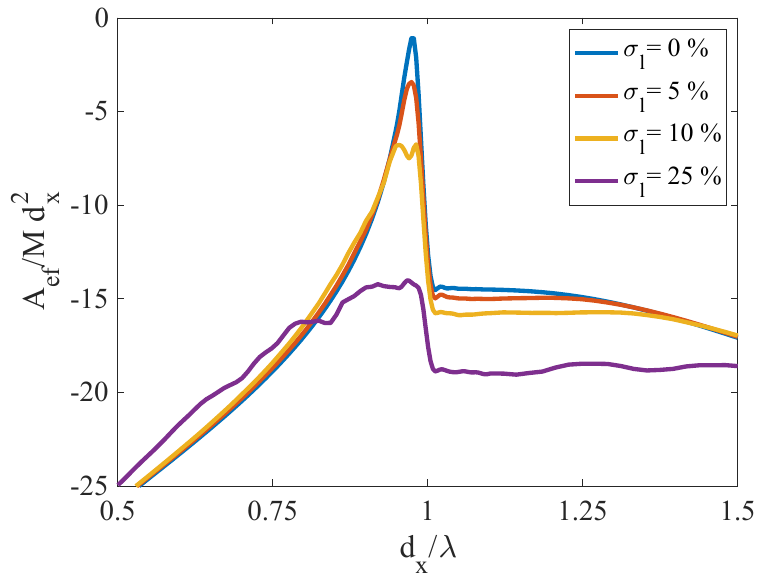
Figure 5. Normalized effective transmitting area of a finite chain of M slots with w s = 0.05 d x and with l s given by a set of random numbers following a normal distribution with mean 0.4 d x for different values of the standard